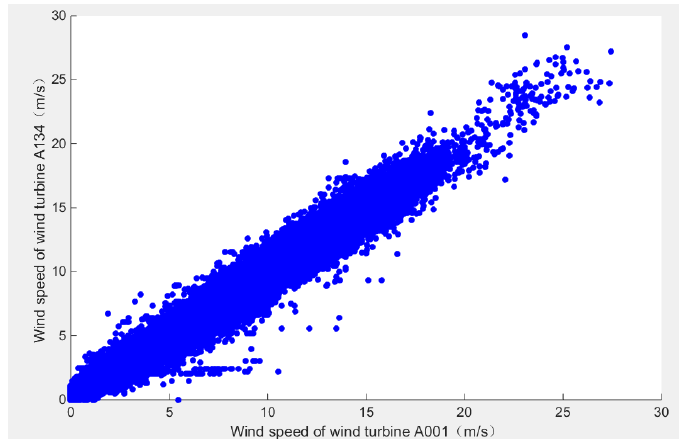
Figure 7. Joint scatter diagram of wind speeds of wind turbines A001 and A134.